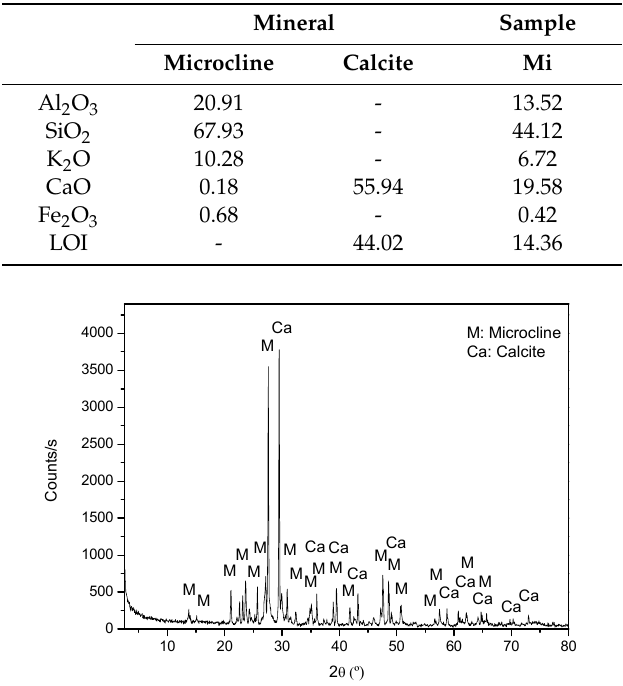
Table 1. Chemical composition (% w / w ) of the starting minerals and the mixture of the minerals (Mi).